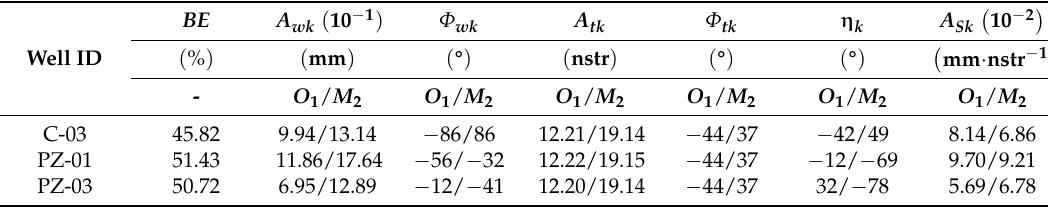
Table 2. Barometric efficiency ( BE ), water level amplitudes ( A wk ), areal strain tide amplitudes ( A tk ), areal strain sensitivities ( A sk ), and phase shift ( η k ) for each k − th tidal harmonic component ( O 1 and M 2 ) for each